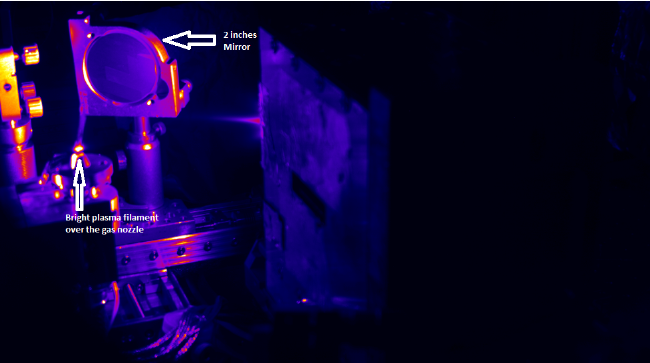
Figure 1. Real image of the VEGA 2 laser-plasma accelerator. The plasma filament is visible above the conical gas nozzle. Given the scale of the picture, the plasma accelerator is as short as a few